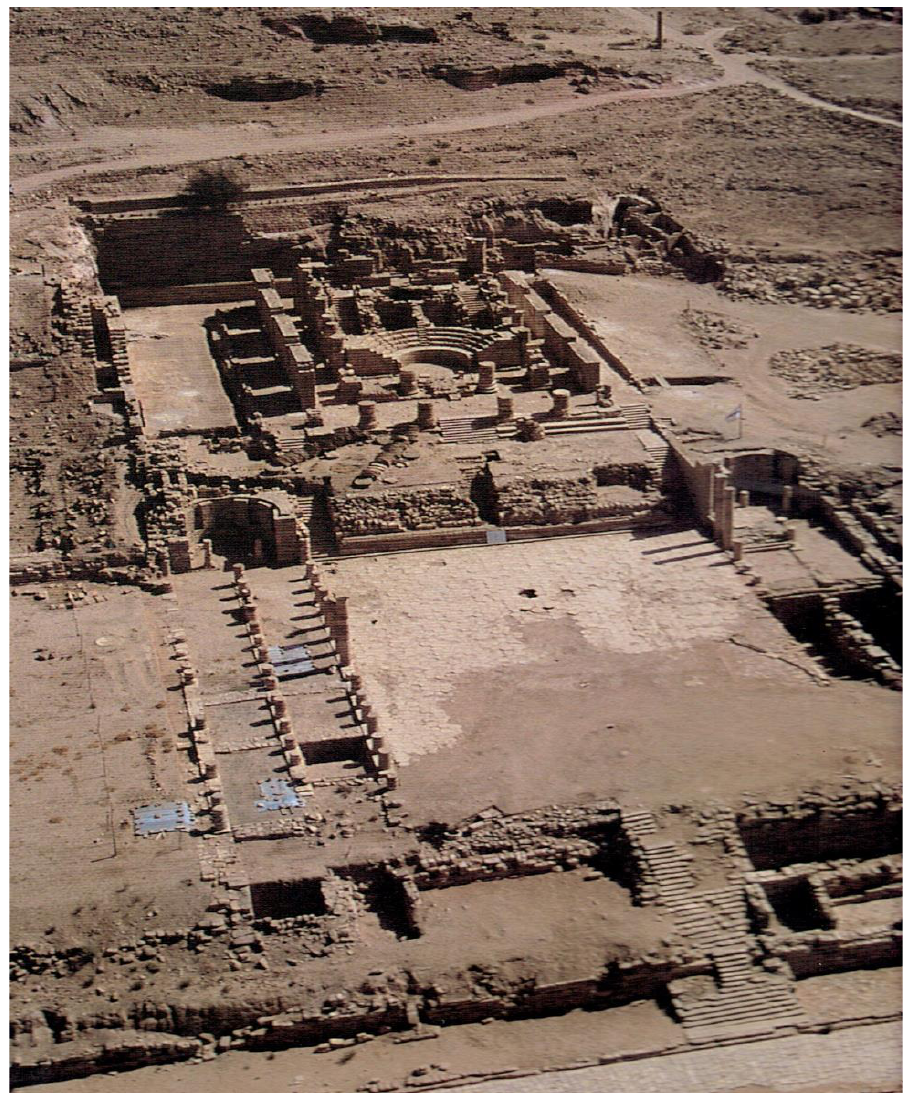
Figure 2. The Great Temple (28, Figure 1). Figure from [2], p.